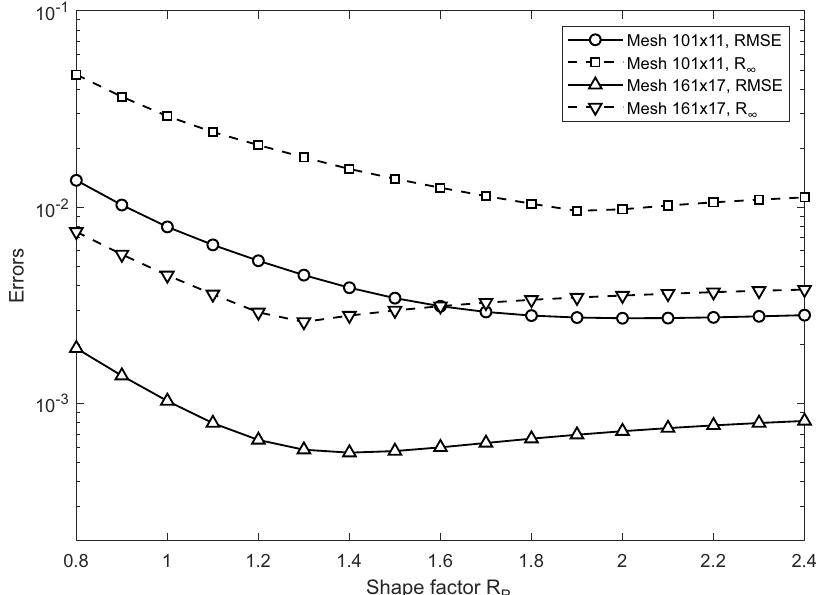
Figure 14. Example No. 3—RMSE and R ∞ as functions of the shape factor R P . The same rectangular domain with the same two different point meshes as well as boundary conditions is used to test the effect of tracer decay; the decay coefficient